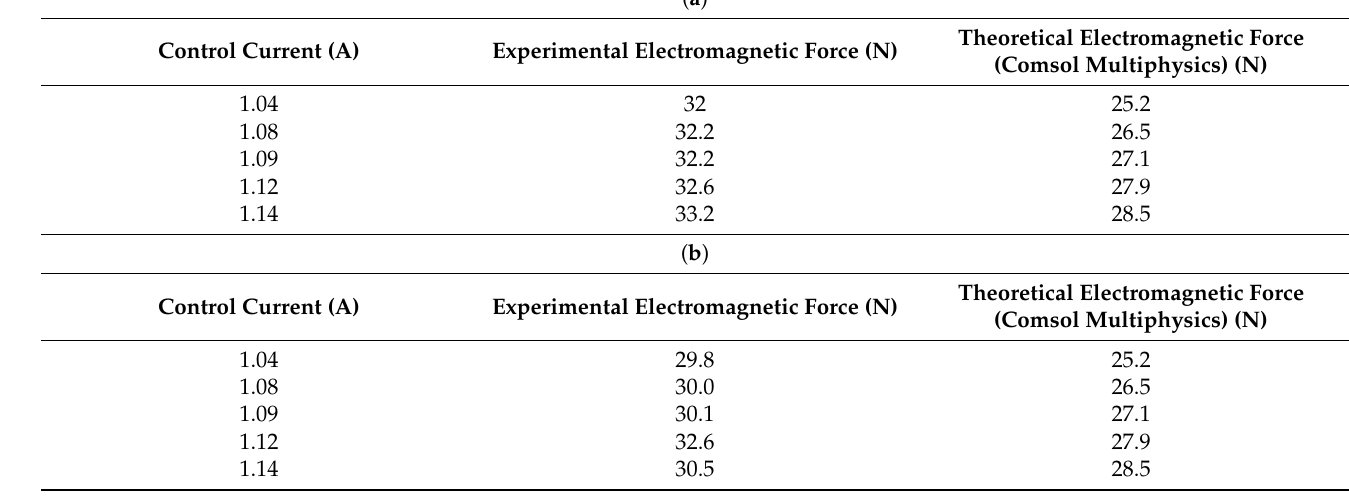
Table 6. The resultant electromagnetic forces generated by the magnetic bearing for different control current values for the constant rotor–shaft raceway displacement equal to − 0.06 mm and coeffi- cients k x and k i were obtained analytically ( a ); the resultant electromagnetic forces generated by the magnetic bearing for different values of the control current for the constant rotor–shaft raceway dis- placement equal to − 0.06 mm; where coefficients k x and k i were obtained using Control Multiphysics software ( b